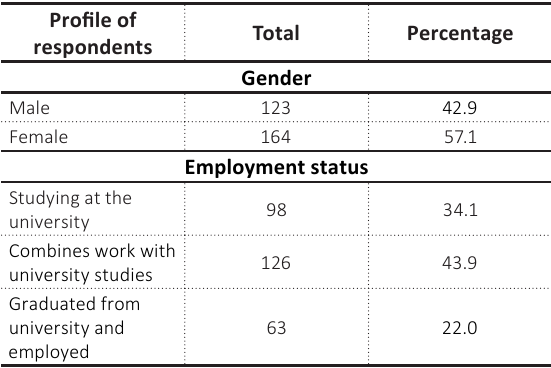
Table 1. Profile of the